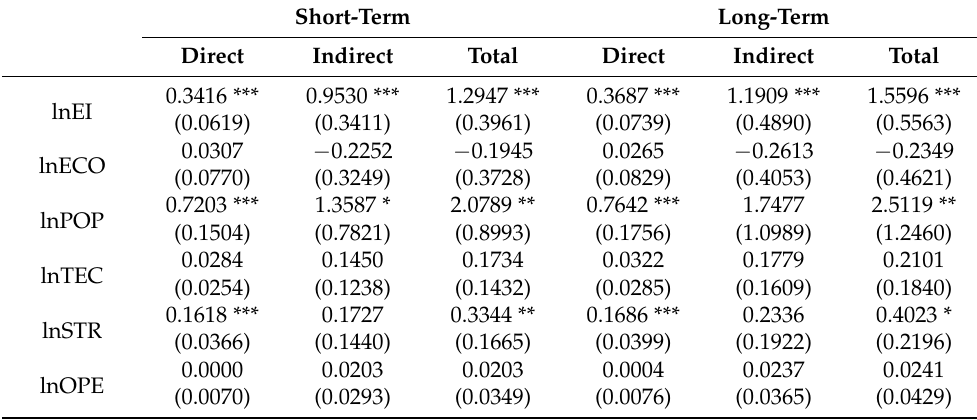
Table 7. The direct and indirect effects of energy intensity on carbon